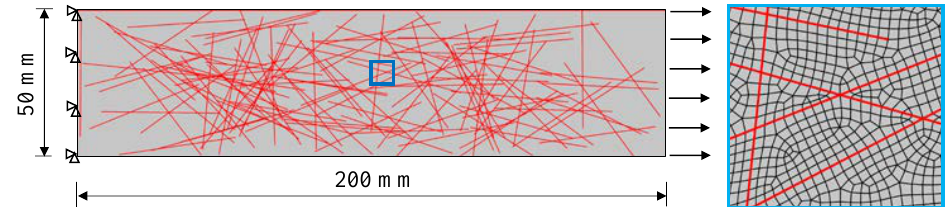
Figure 25. The FE model of SFRC with random fibres under tension.